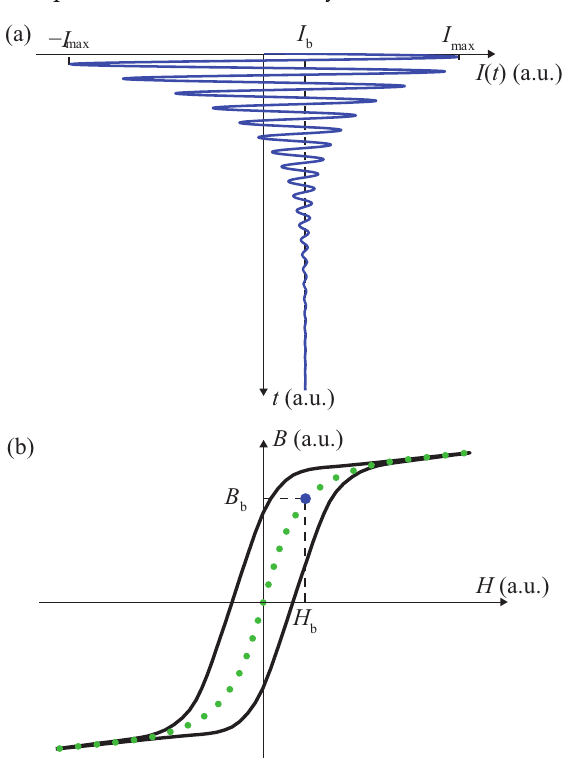
Figure 2. Magnetic excitation for the anhysteretic process ( a ), and the corresponding anhysteretic point (blue) of the complete anhysteretic curves (green) ( b ). This curve is included in the major magnetic loop. “a.u.” stands for “arbitrary